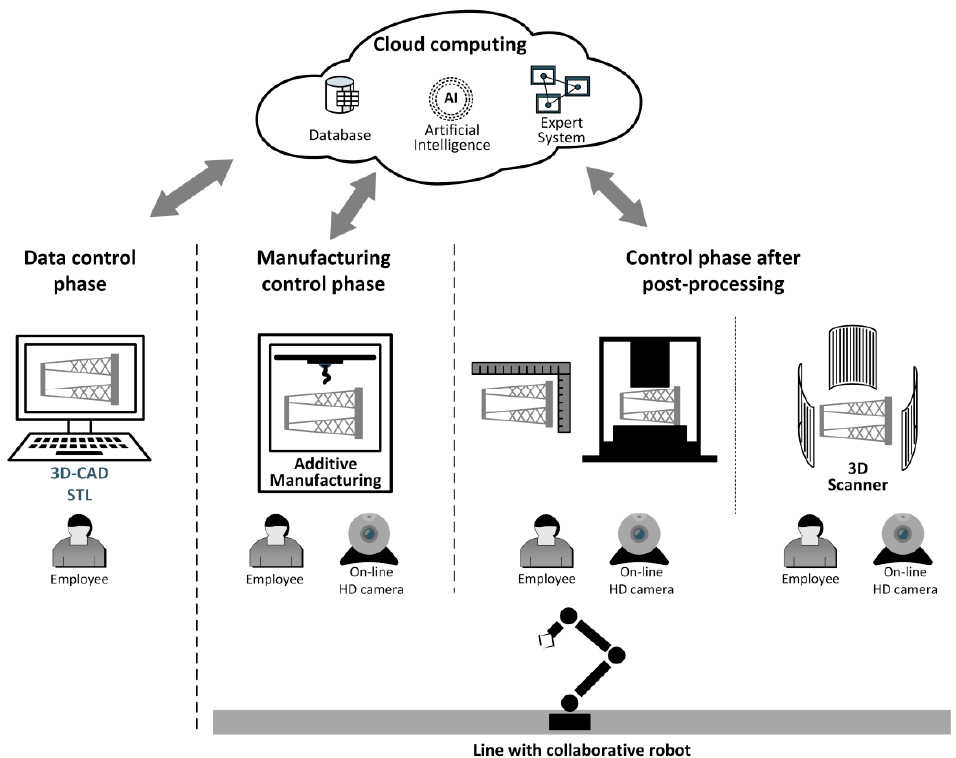
Figure 3. Manufacturing process control in additive manufacturing in the context of Industry 4.0.